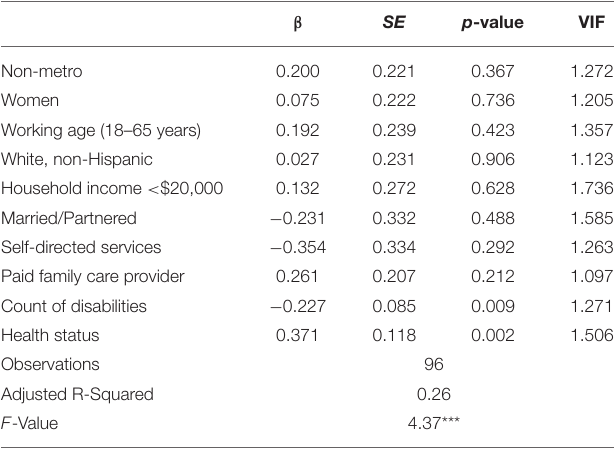
TABLE 3 | Linear regression predicting satisfaction with community